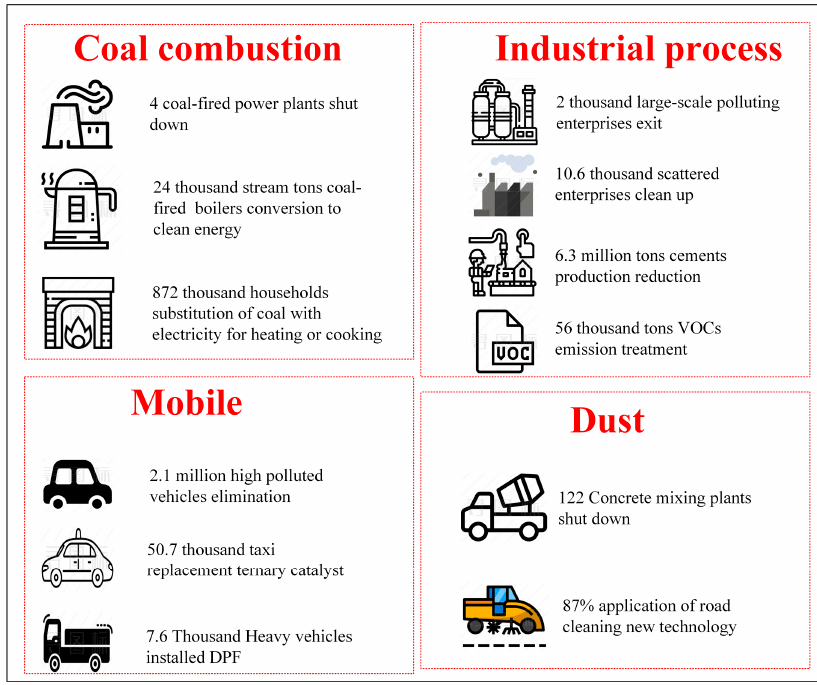
Figure 1. Main control measures and activity level variation taken by clean air action plan.